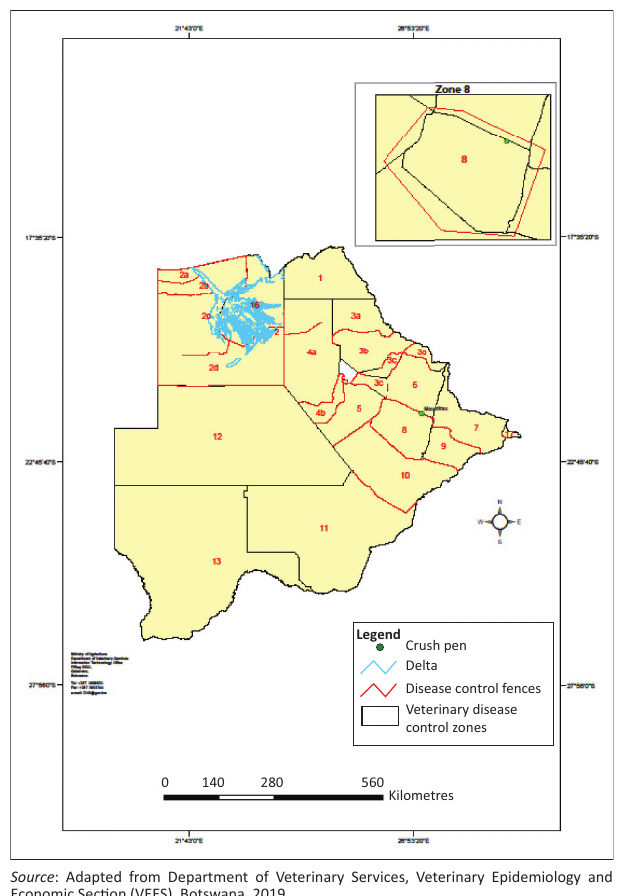
FIGURE 1: Map of Botswana showing disease control zones and location of Mmaditau